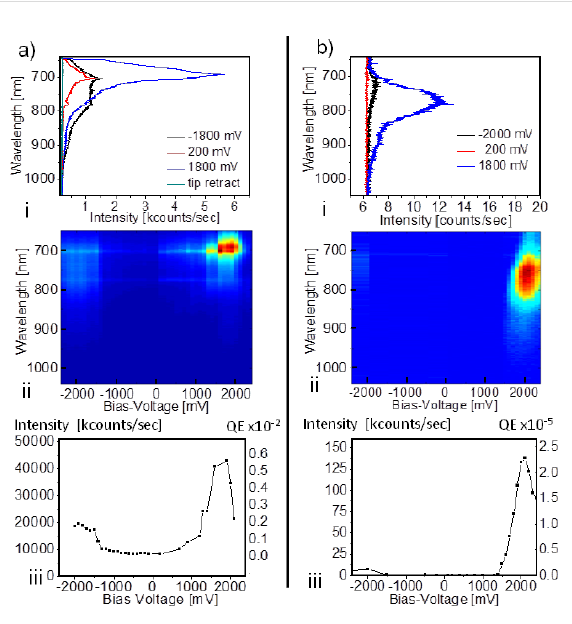
Figure 2: TERS spectra (a) from the tunneling junction excited at λ = 632.8 nm as a function of the bias voltage (i), (ii) with the respec- tive spectrally integrated intensity trajectory (iii). Electroluminescence spectra excited by inelastic tunneling (b) without laser illumination as a function of the bias voltage (i), (ii). All spectra were recorded with the same tunneling current (1 nA) and are normalized to 1 s integration time. The corresponding QE are defined as the number of Stokes- shifted photons per tunneling electron and can directly be compared for the two situations. Note the very different intensity